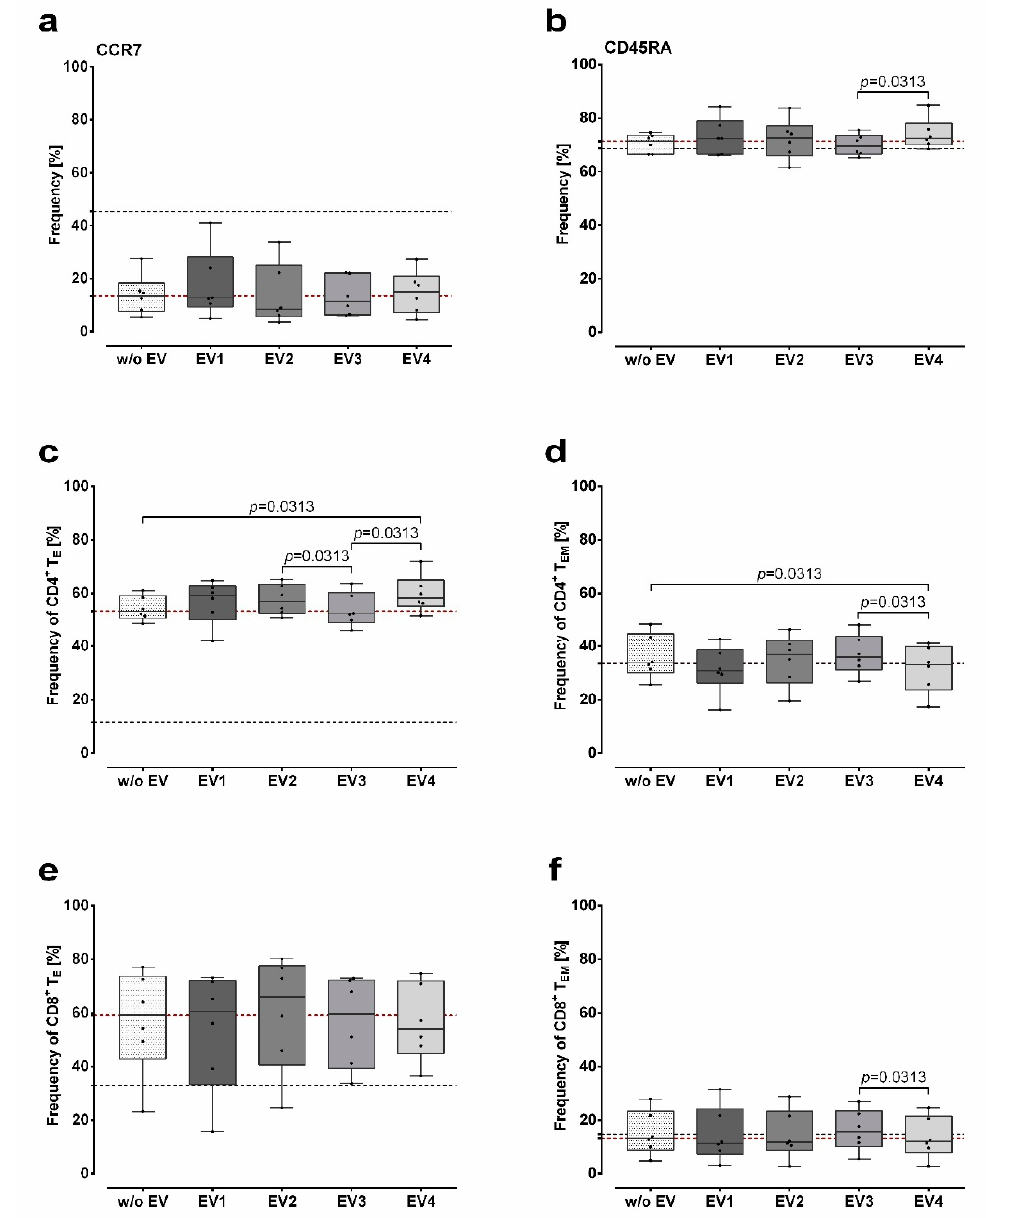
Figure 3. Modulation of CD45RA expression on T cells by MSC-EVs. ( a , b ) Effect of four different mesenchymal stem/stromal cells–extracellular vesicles (MSC-EV) preparations (EV1–EV4) on the frequency of CCR7 and CD45RA expressing T cells and ( c – f ) capacity to modulate CD4 + and CD8 + effector (T E ) and effector memory (T EM ) T cell subsets upon 4 h of PMA/Ionomycin stimulation. Frequencies of cell populations (%) are presented as median with minimum and maximum. Black dotted line indicates the median frequency of a certain population obtained without PMA/Ionomycin stimulation; red dotted line indicates the median frequency of a certain population obtained after PMA/Ionomycin stimulation in the absence of EV. Statistical analysis was performed by Wilcoxon test. 2.3. Modulation of the Cytokine Response of T cells Subsets by MSC-EVs upon PMA/Ionomycin Stimulation